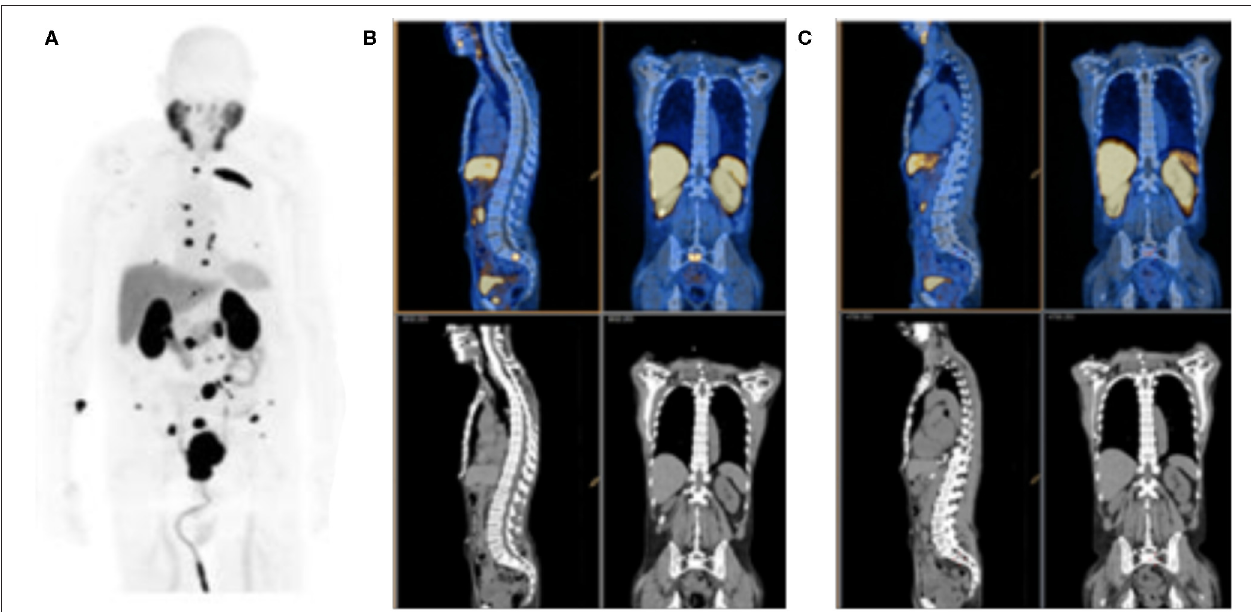
FIGURE 4 | PSMA PET Imaging. (A) Detection of prostate cancer lesions with [ 18 F]DCFPyL, along with uptake in kidneys, salivary gland and liver. (B) Pre-treatment [ 68 Ga]PSMA-11 and (C) post-treatment PET/CT, top, and CT, bottom, scans obtained on day 9 after initiating combined anti-androgen hormone therapy. Reproduced from (A) ( 40) and (B,C)